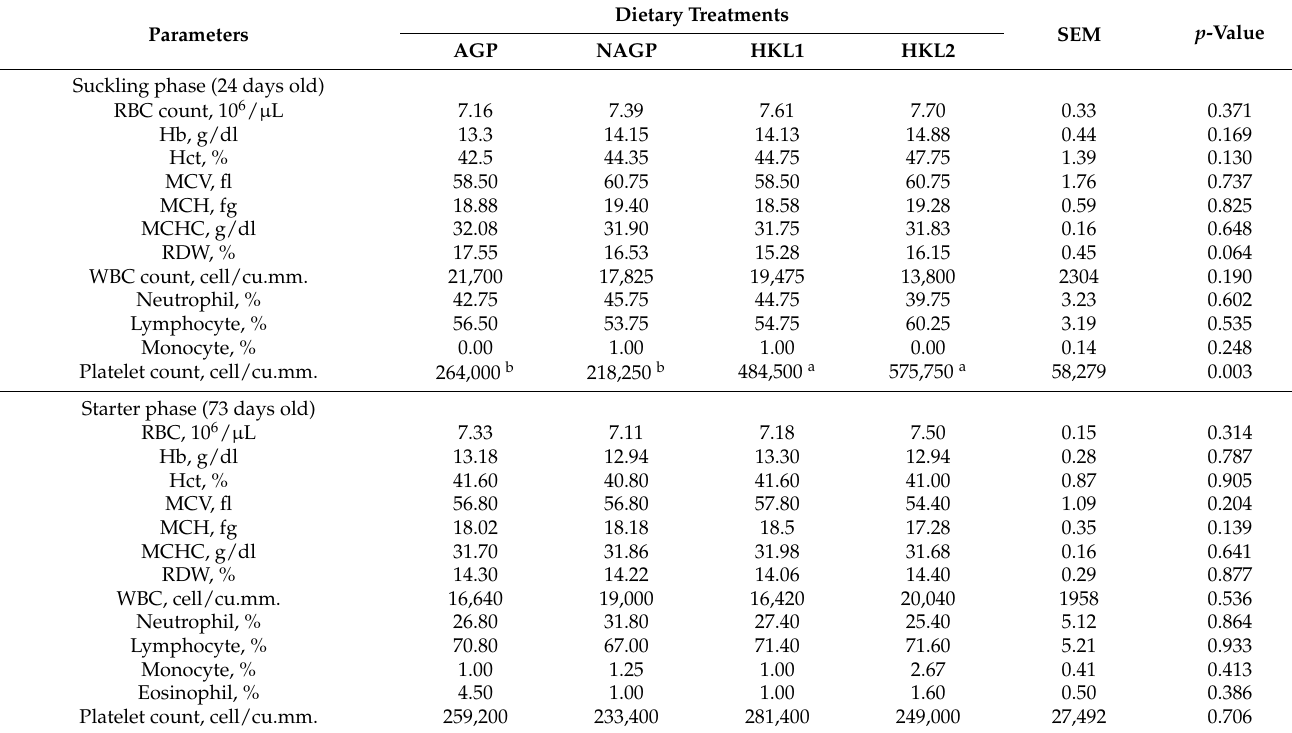
Table 6. Effects of the dietary treatments on the hematological parameters of the pigs at the end of the suckling phase (24 days old) and starter phase (73 days